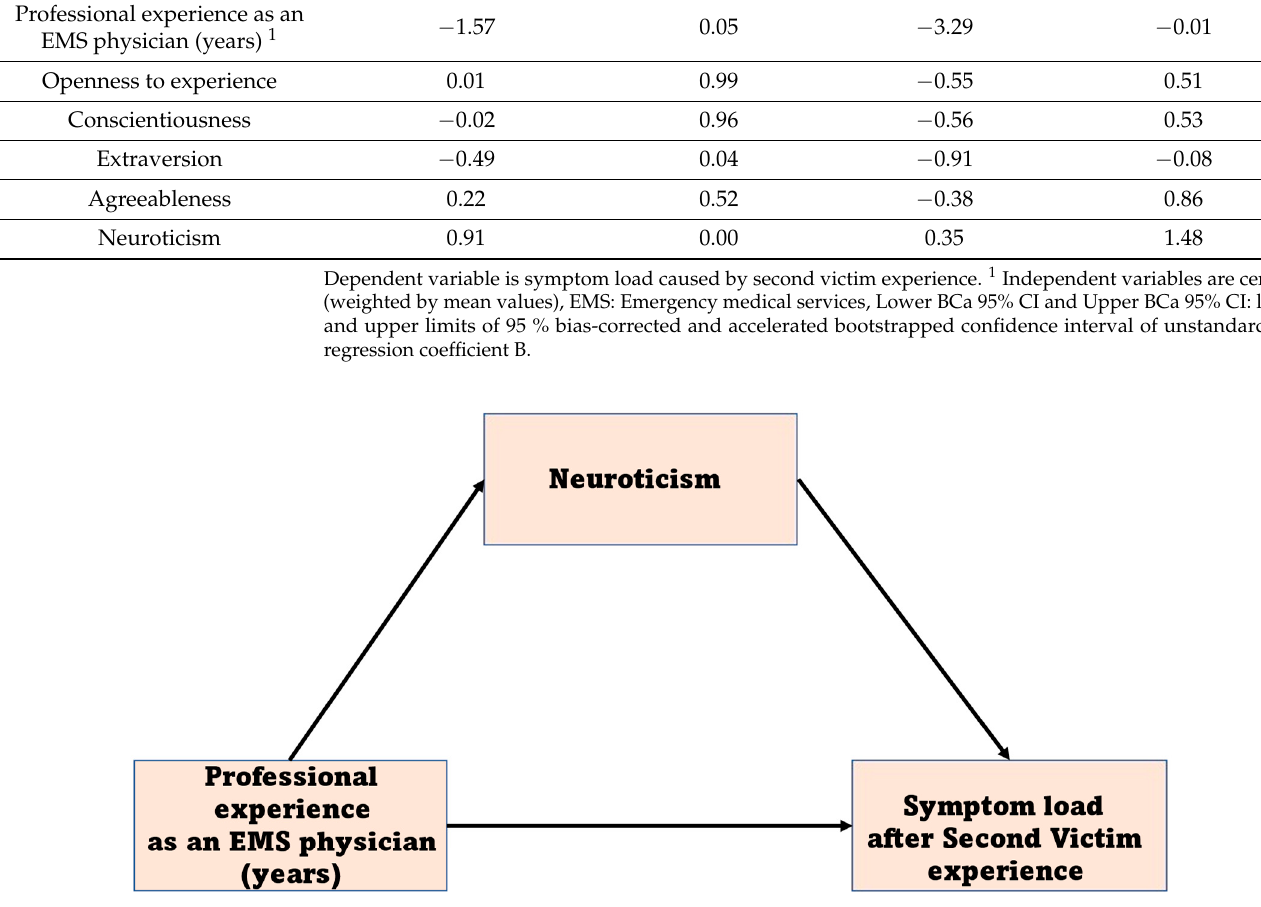
Figure 1. Mediation model. EMS: Emergency medical services, Neuroticism: One out of Big Five Personality Traits, Symptom load: the sum of symptoms after second victim experience. Table 5. Indirect, direct, and total effects of length of professional experience as an EMS physician in years on symptom load caused by second victim experience. Relationship